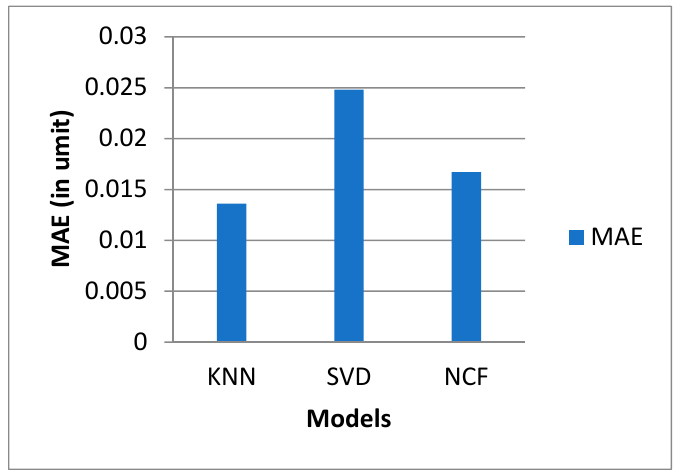
Figure 9. Performance results of different models in terms of MAE in 70:30 training–testing scenario.